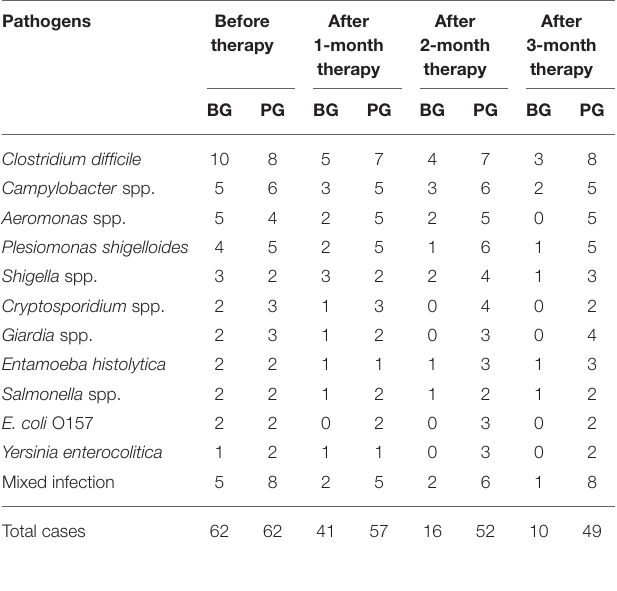
TABLE 3 | The effects of blueberry on gastrointestinal pathogen infection. Pathogens